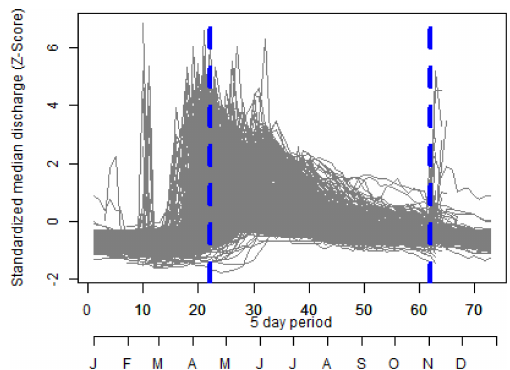
Figure 4. Standardized median streamflow for 5d periods from the 395 hydrometric stations. The flow from each station was standard- ized by removing the mean and dividing by the standard deviation. Only the period between 21 April and 1 November (indicated by the region between the blue dashed lines) is considered, as seasonally operated stations have no observations during winter months.